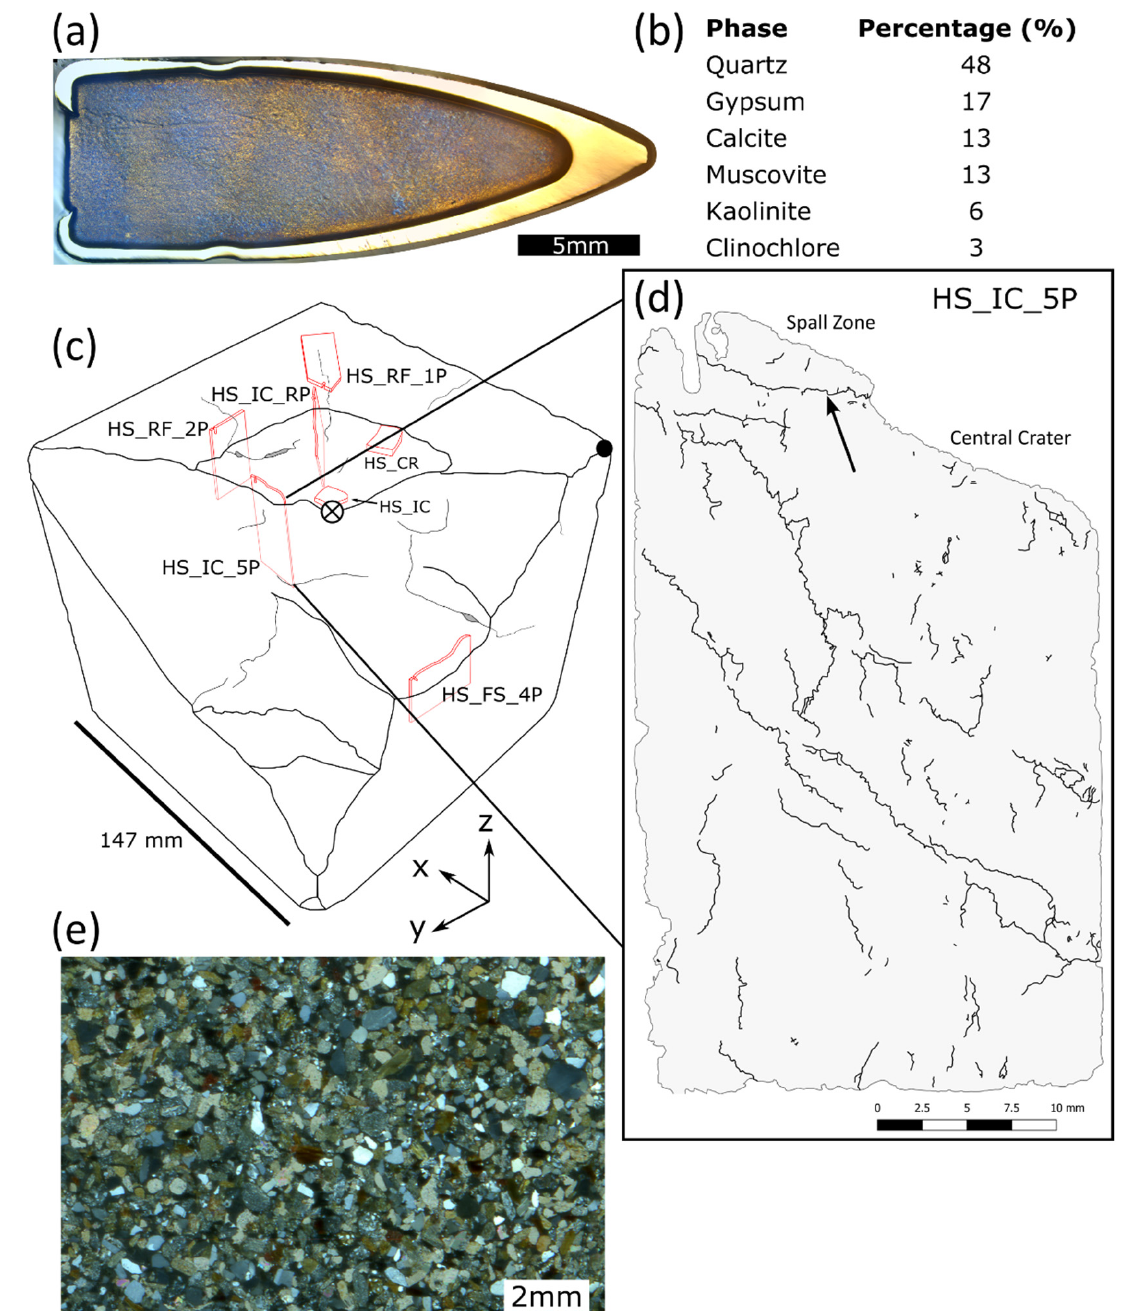
Figure 1. ( a ) Reflected light micrograph of a cross-section through a typical ‘soft core’ 7.62 × 39 mm projectile. The outer brass jacket surrounds the grey lead core. ( b ) Summary table of constituent minerals in the Huesca sandstone (taken from [25]). ( c ) Schematic figure of the Huesca sandstone block after being shot with 7.62 × 39 mm ammunition from a range of 200 m. Red outlines indicate the position and orientation of thin sections taken from within the sample. Crossed circle marks the centre of the crater. Solid circle indicates origin of 3D coordinate scheme. ( d ) Digitised fracture network from sample HS_IC_5P used in NetworkGT to calculate P xy values. Black arrow indicates a spall fracture below an incipient spall fragment (Complete fracture maps and transmitted light micrographs of each sample are available in Supplementary Information Figures S1–S5). ( e ) Transmitted light thin section micrograph of undamaged Huesca sandstone taken under cross polarised